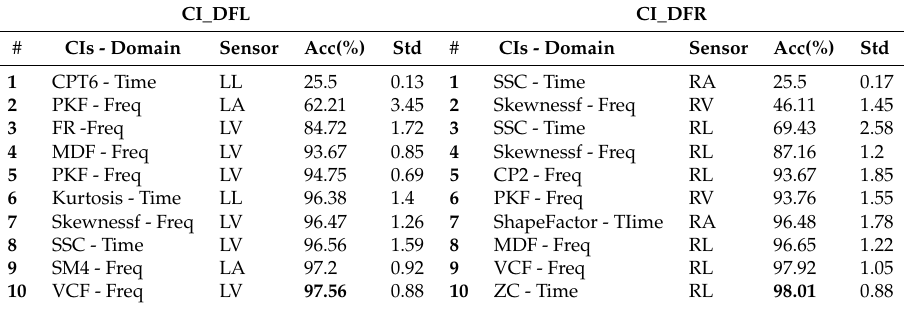
Table 9. Top 10 features and accuracies average over time and frequency domain using left and right